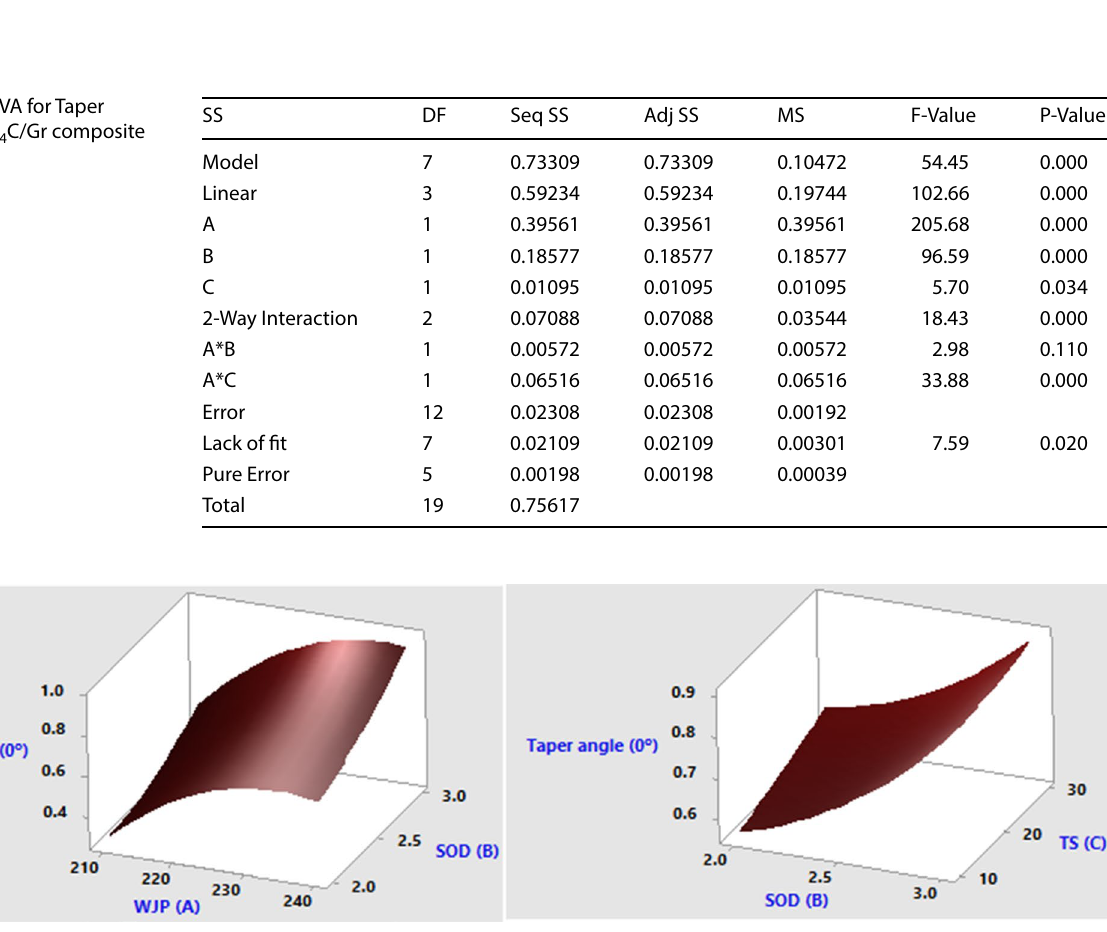
C/Gr composite 4